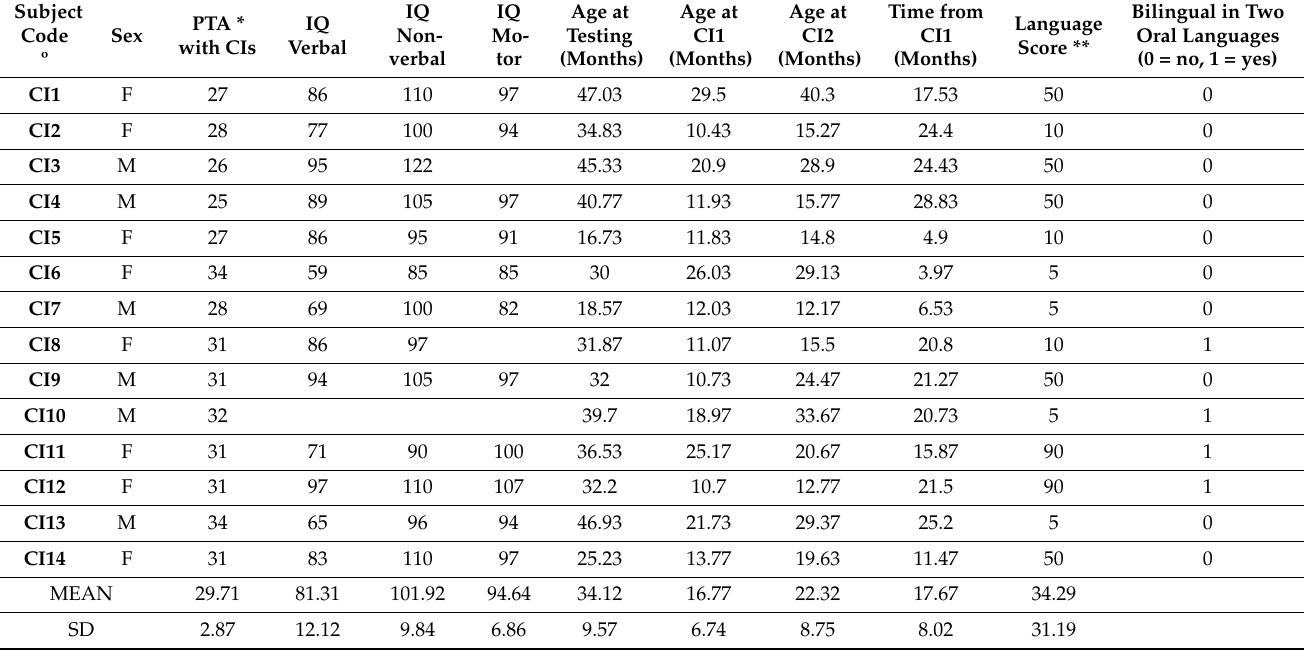
Table 1. Participant data for the CI